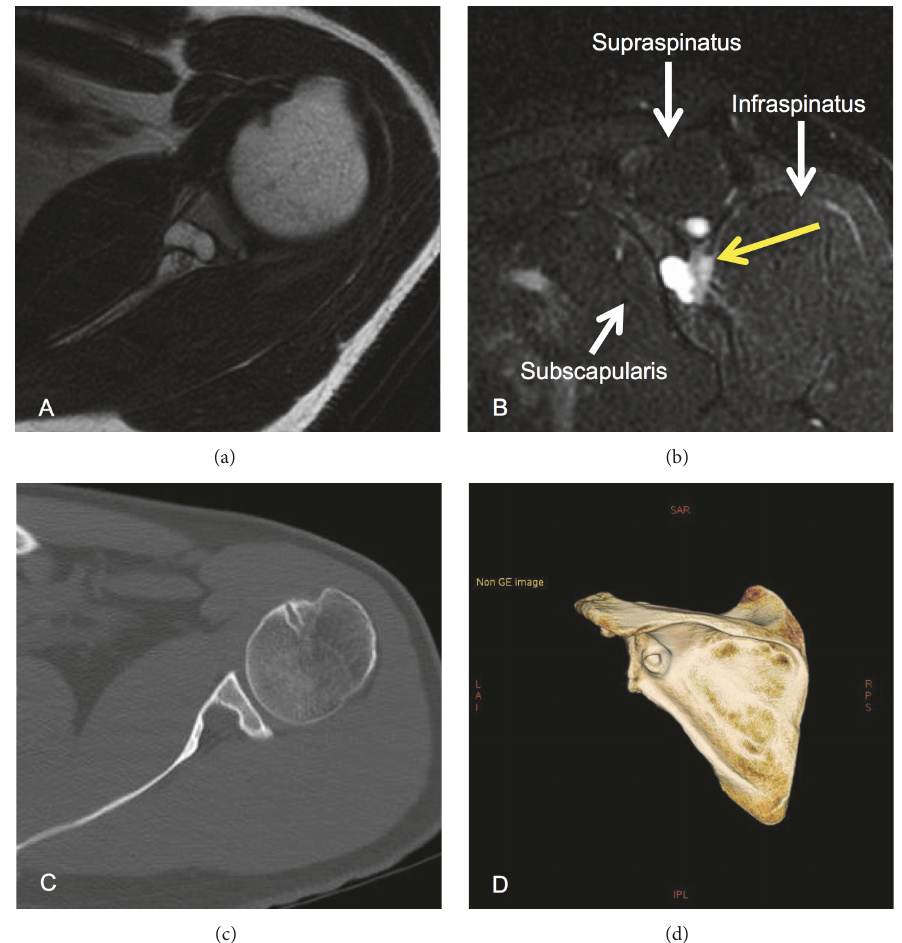
Figure 2: (a) Magnetic resonance (MR) T2-weighted axial image of the left shoulder shows a high intensity area at the glenoid. (b) MR T2- weightedsagittalimageoftheleftshouldershowsthattheintraosseouslesionislinkedtothespinoglenoidnotch.(c,d)Computedtomography (CT) axial and 3-dimensional CT images of the left shoulder show a bone cystic lesion of the glenoid with cortical bone destruction linked to the spinoglenoid